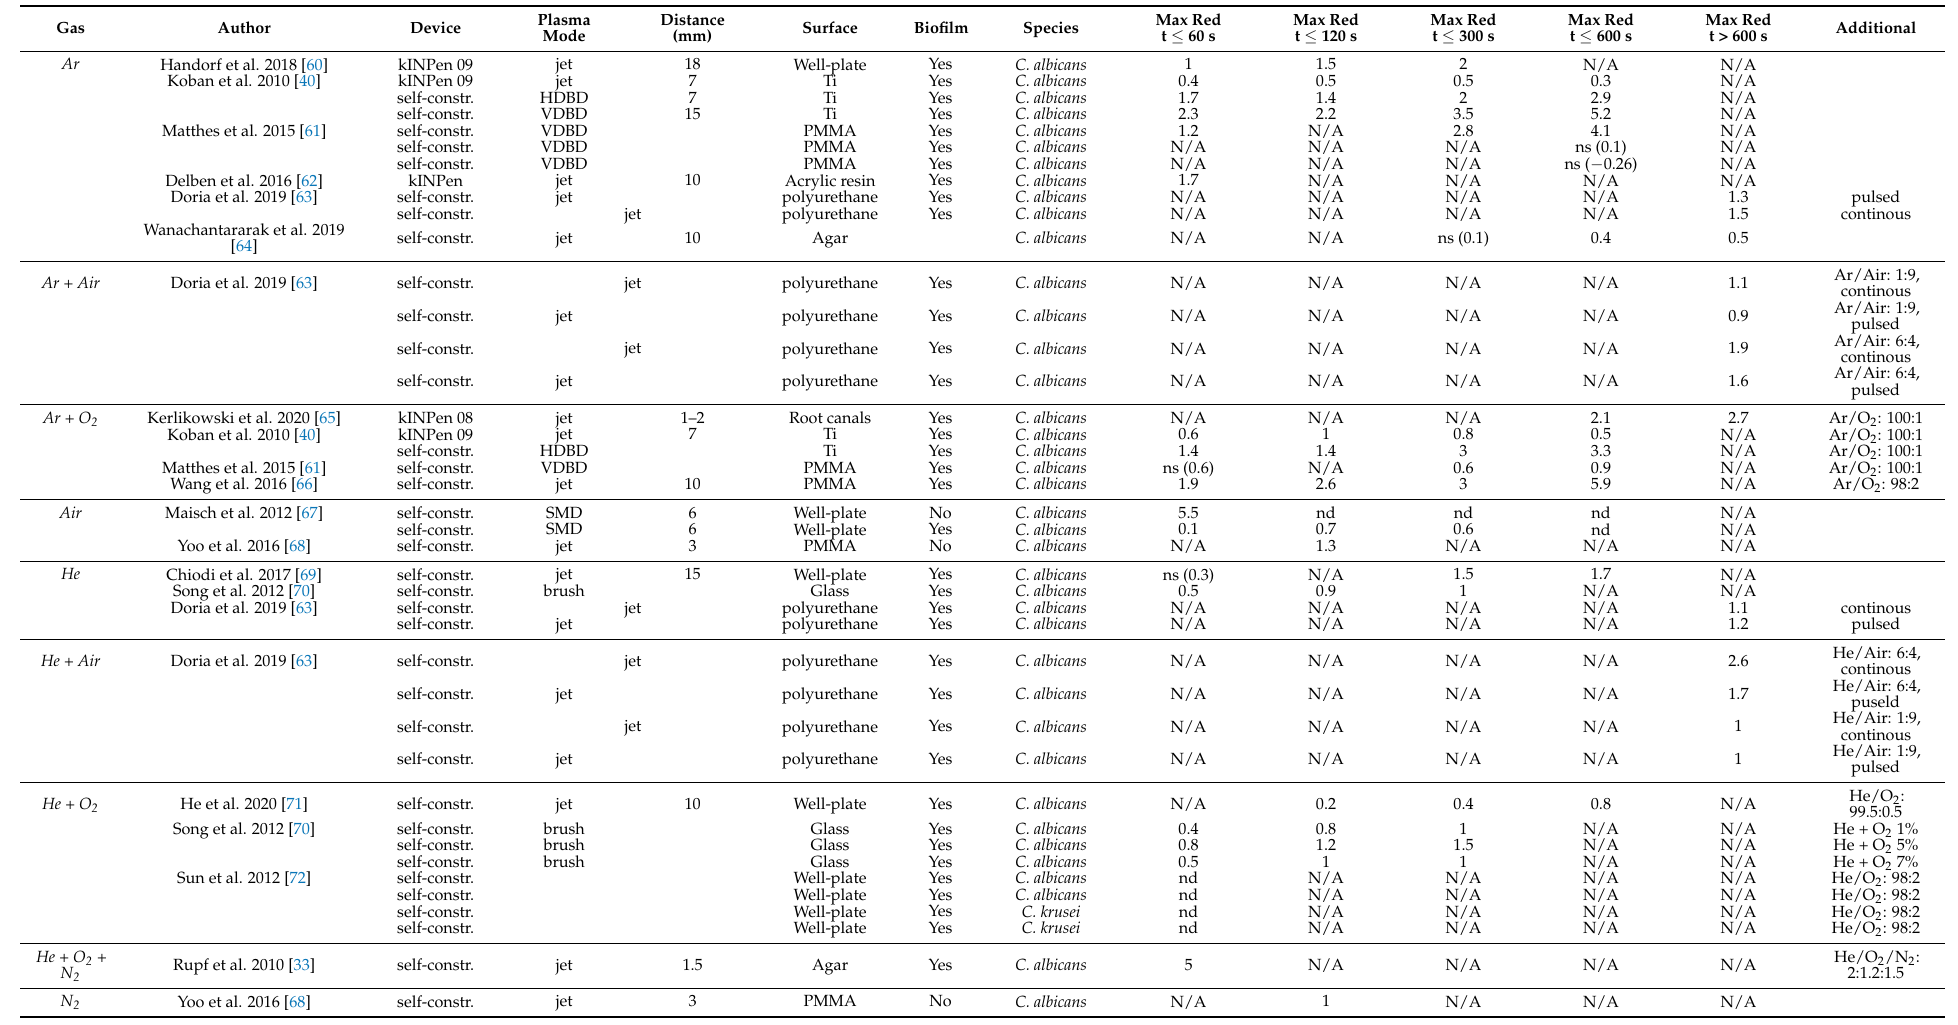
Table 5. Effect of CAP on C. albicans ; Abbreviations: DBD: dielectric barrier discharge; HDBD: hollow dielectric barrier discharge; max red: maximal reduction; PMMA: polymethyl- methacrylate; N/A: not available; nd: non-detectable; ns: non-significant; self-constr.: self-constructed; Ti: titanium; VDBD: volume dielectric barrier